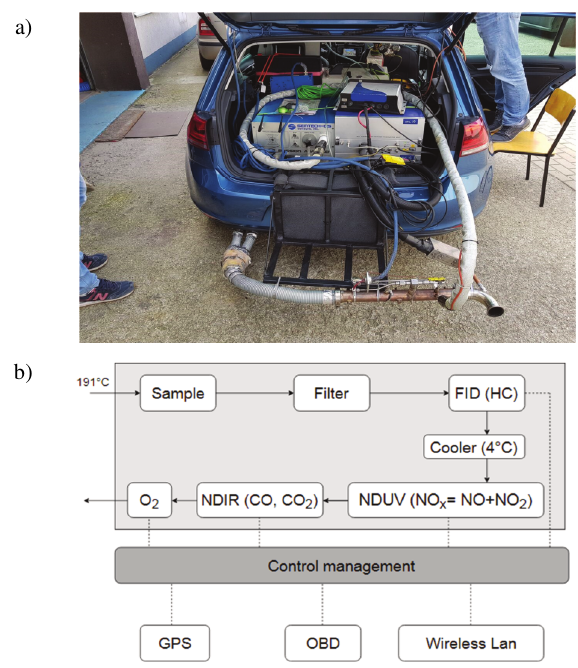
Fig. 2. SEMTECH DS analyzer: a) device view, b) operation diagram